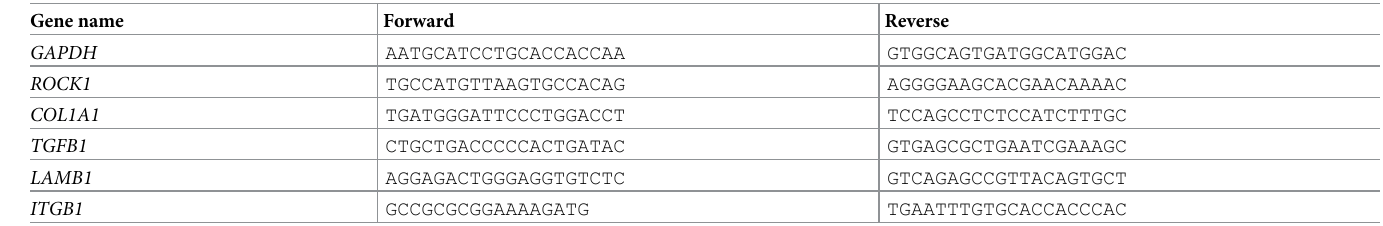
Table 1. Primers for